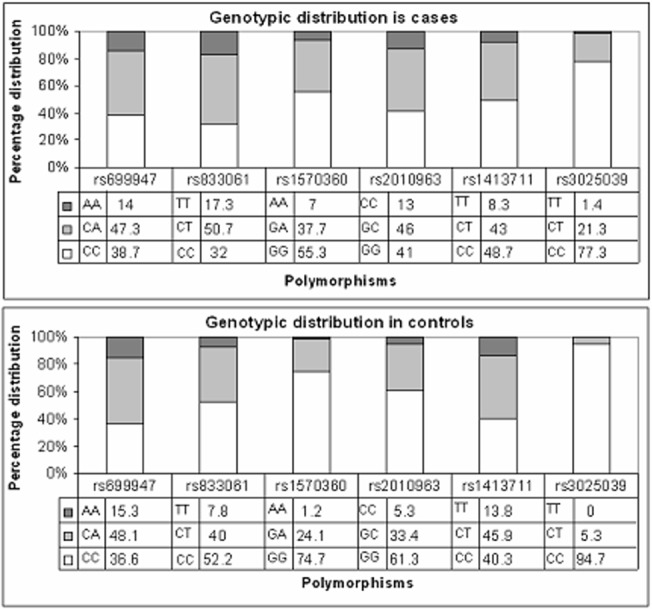
Genotypic frequencies in cases and controls.